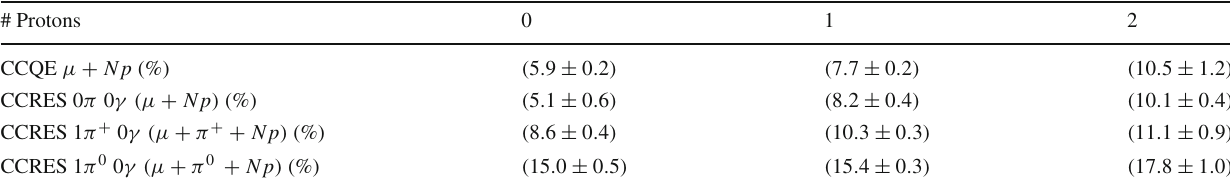
the neutrino-induced hits must be removed, or sufficient hits removed to cause a change in the classification of the neutrino-induced final state